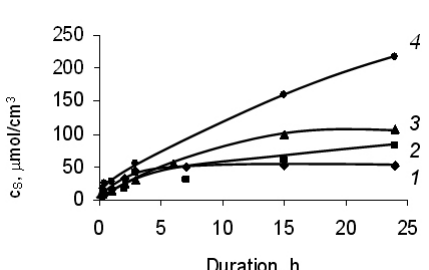
Figure 14. Adsorbtion isotherms of sulfur on PA surface at 20 o C as